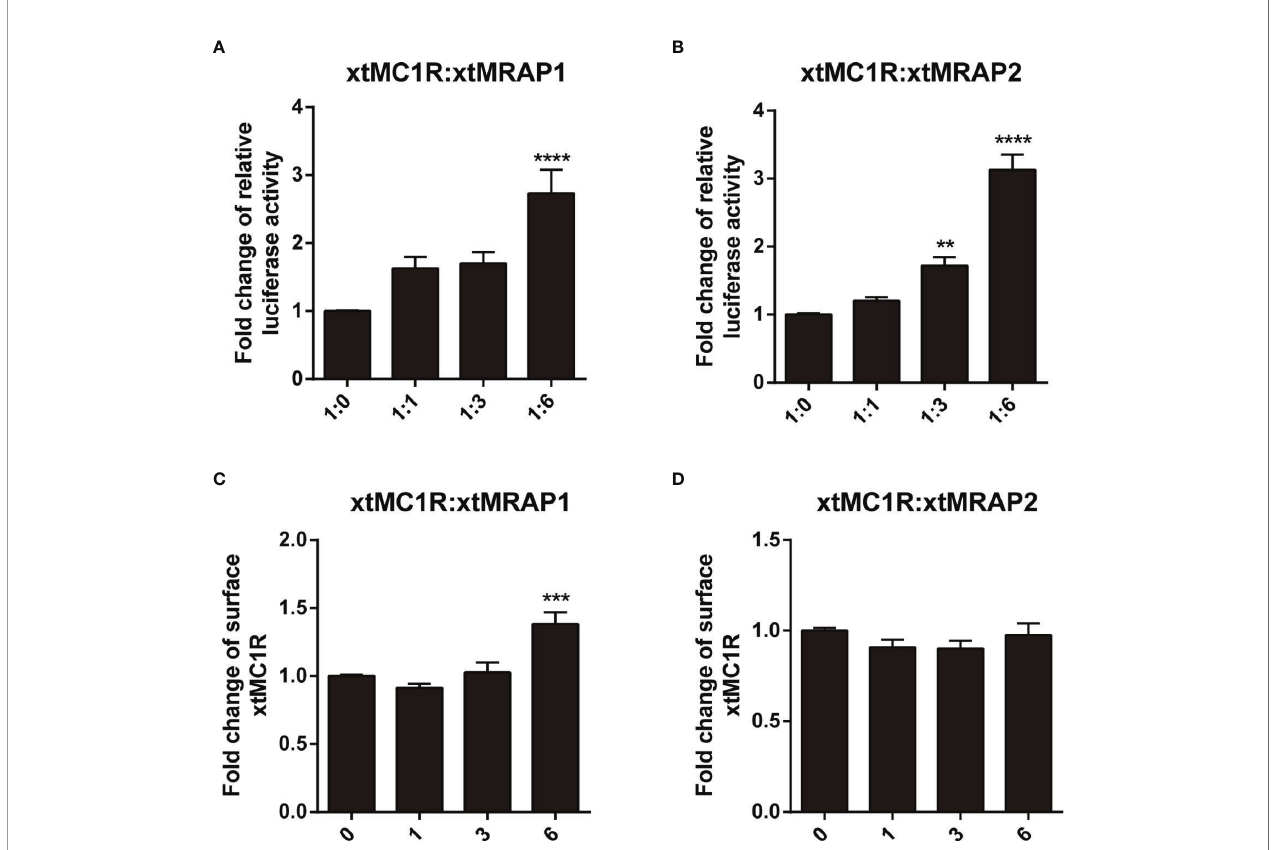
FIGURE 7 | Measurement of the constitutive activity and surface translocation of xtMcar by xtMrap proteins. The constitutive activity of xtMc1r in the presence of xtMrap1 (A) or xtMrap2 (B) at ratio of 1:0, 1:1, 1:3, and 1:6. Surface expression level of the HA-tagged xtMc1r in the presence of xtMrap1 (C) or xtMrap2 (D) at ratio of 1:0, 1:1, 1:3, and 1:6. Data were represented as the mean ± SEM from three independent experiments. **p < 0.01, ∗∗∗ p < 0.001 and ∗∗∗∗ p <